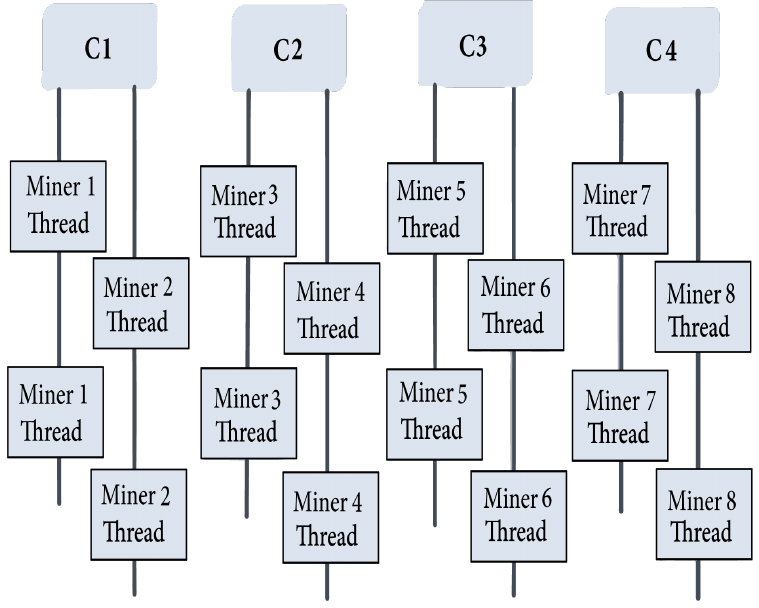
Figure 12. Threads running concurrently on CPU cores, simulating miners competing to add a new